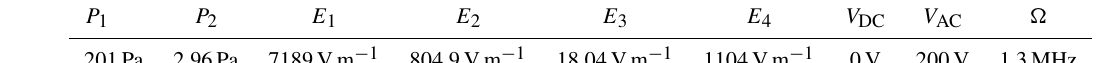
Table 1. Parameters configuration of APi used in the CLOUD10 experiments and adopted in the simulations.